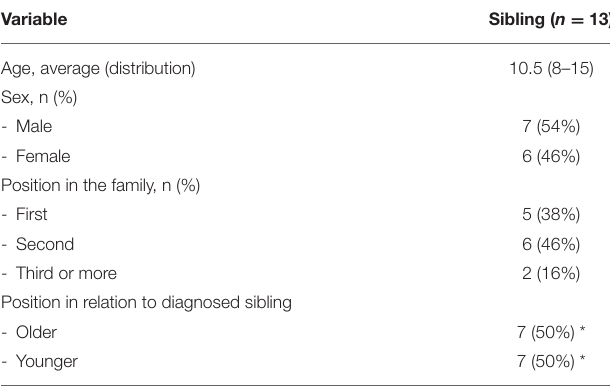
TABLE 1 | Demographics of participating siblings. Variable